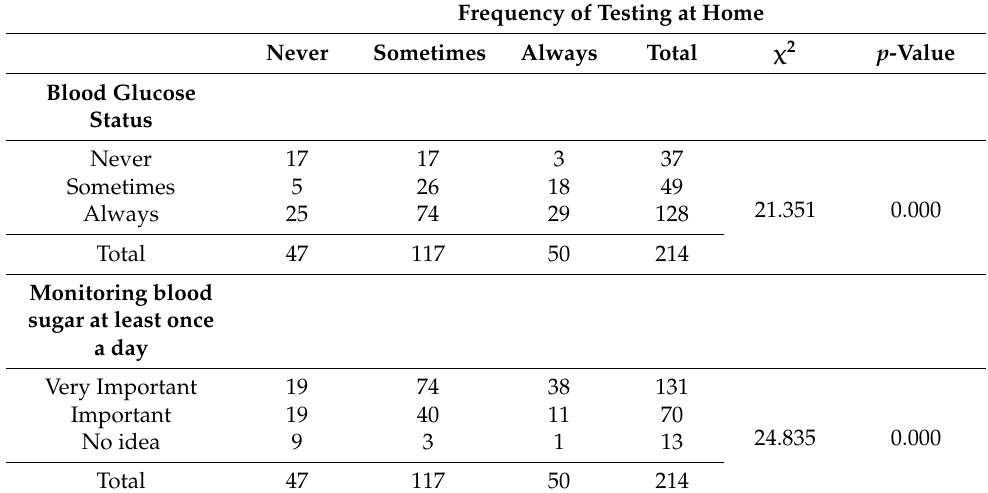
Table 3. Cross tabulation combination